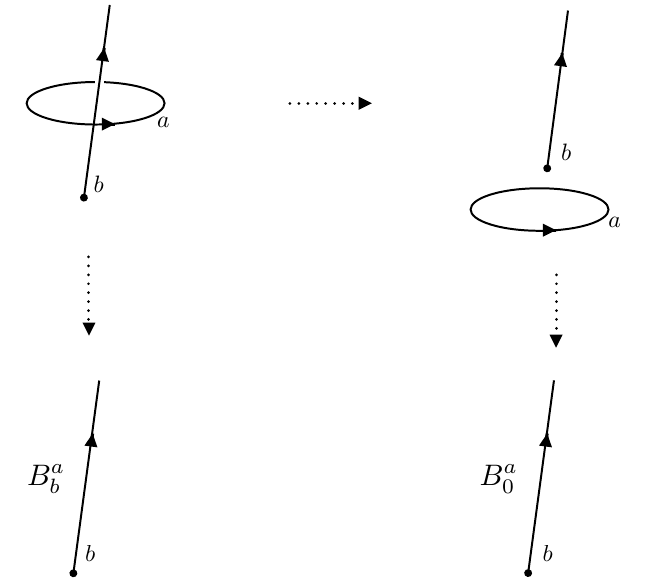
Figure 6 . Topological and endable lines. If L b is endable, then L a may be either shrunk to a point on the line L b (bottom left), introducing a braiding factor B a (top right) and then shrunk to a point (bottom right), introducing a braiding factor B a topological, these two shrinking processes must agree, so we must have B a